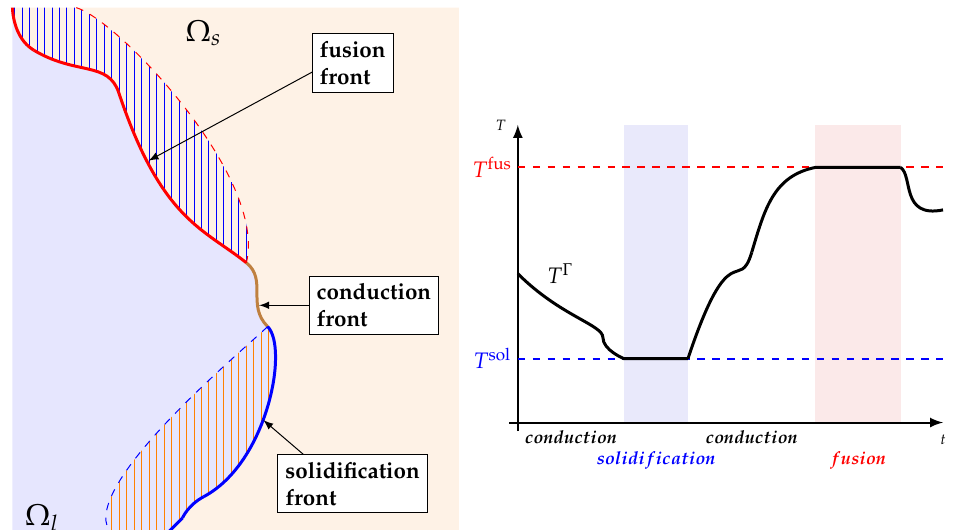
Figure 1. Left panel: interface Γ at a given time t (continuous line). Blue/red/brown colors for solidification/fusion/conduction states, interface Γ at a given time t + ∆ t > t in dotted line, areas of phase changes in hatched—Right panel: interface temperature T Γ in function of time (black line), fusion period represented by the red zone and solidification represented by the blue zone.